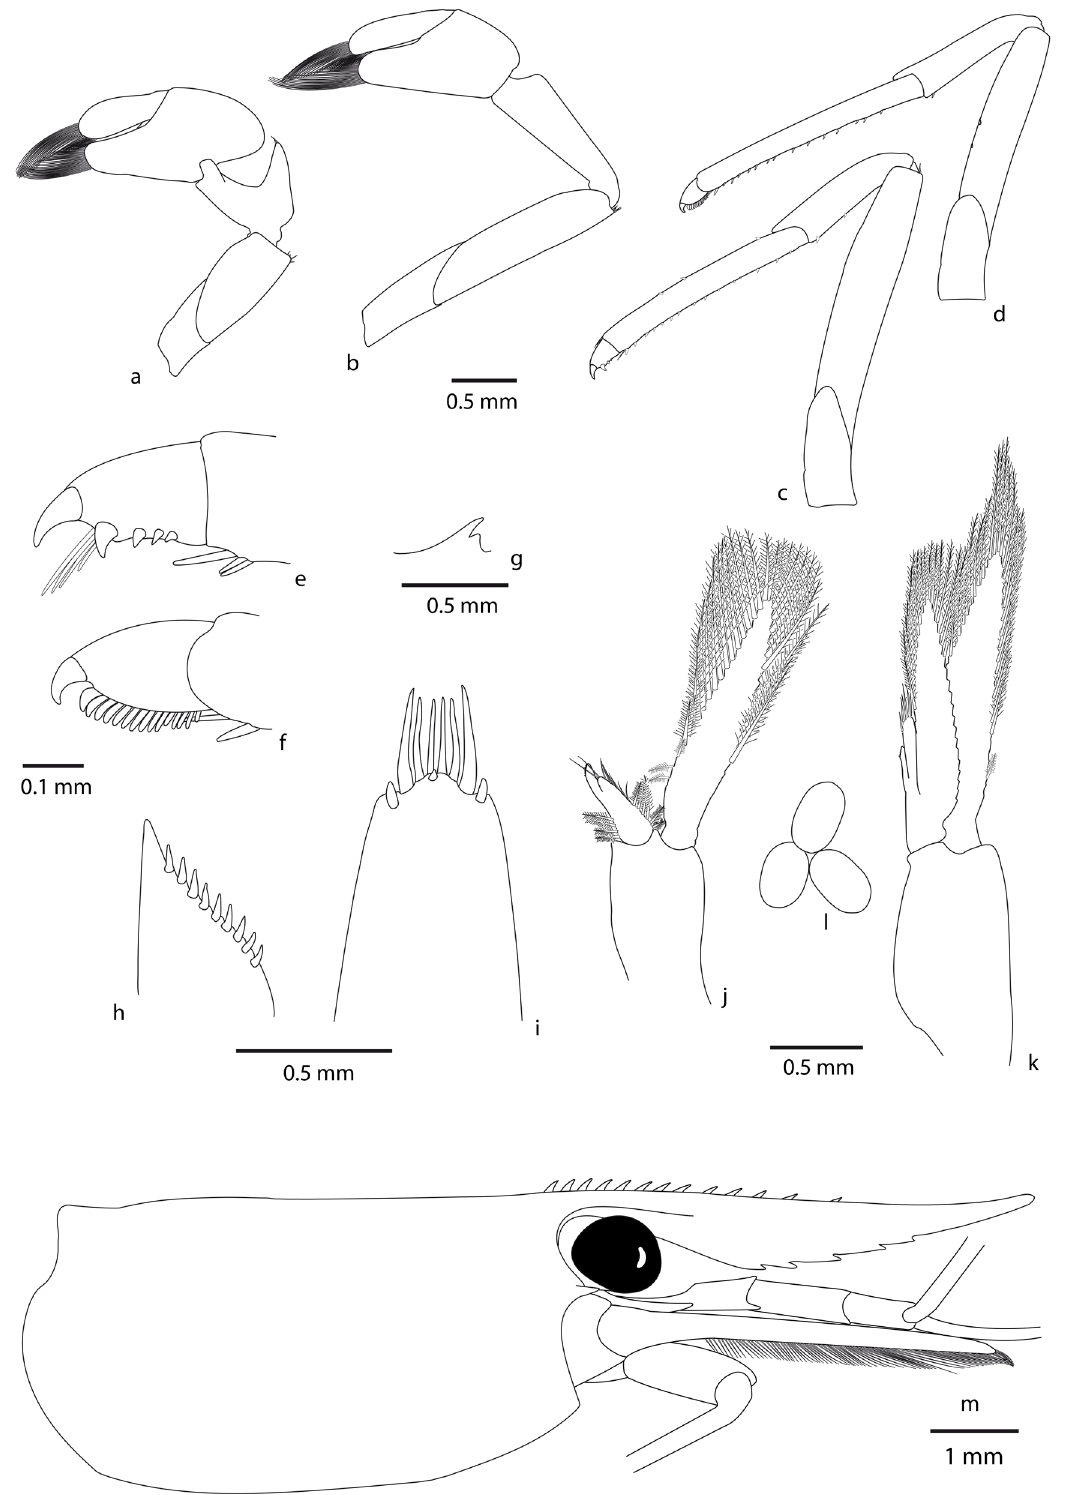
Fig. 3. Caridina barakoma sp. nov. a . First pereiopod. b . Second pereiopod. c . Third pereiopod. d . Fifth pereiopod. e . Dactylus of third pereiopod. f . Dactylus of fifth pereiopod. g . Pre-anal carina. h . Uropodal diaeresis. i . Telson. j . First male pleopod. k . Second male pleopod. l . Eggs. m . Cephalothorax. MNHN- IU-2014-20807 (a–i, l–m) and MNHN-IU-2014-20805